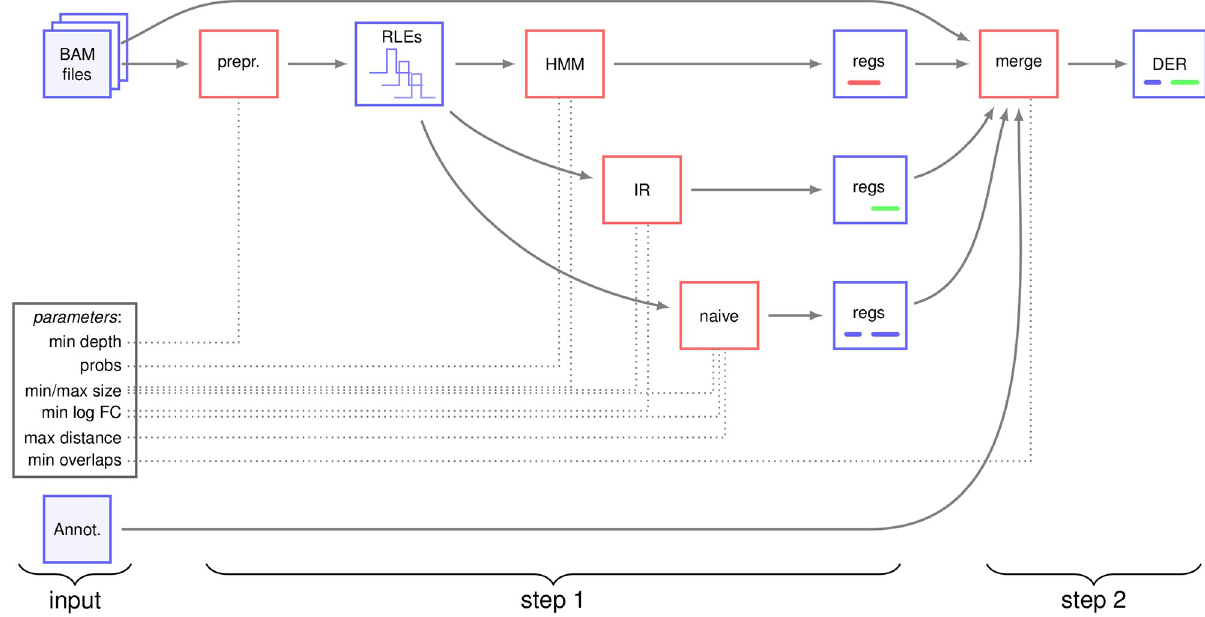
Fig 1. Outline of the method. Files and intermediate data are displayed in blue rectangles, algorithms are displayed in red rectangles, and parameters are in the black rectangle. Arrows show the data which are used by each algorithm. The first step transforms BAM files into coverages, stored as run- length encoding. The coverages are then used by different methods (naive, HMM, IR), which independently produce differentially expressed regions, stored are lists of genomic intervals. The user can also add an annotation, which is transformed into putative regions. In a second step, these regions are merged. These regions may overlap, since they have been predicted by several, independent tools. We compute the p-values of the differential expression, and, in case of overlap, choose the regions with the lowest p-values. The parameters (described hereafter) used by each algorithm are in shown dotted lines. prepr.: pre-processing; RLE: run-length encoding: regs: regions; DER: differentially expressed regions.